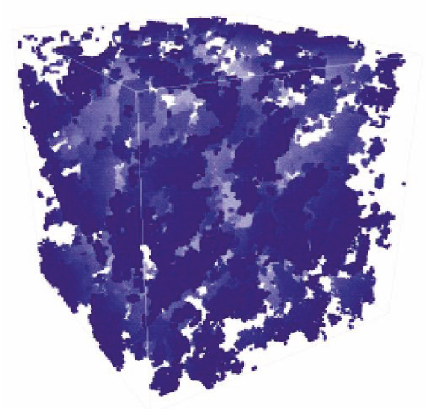
Figure 11: Reconstruction result of the 3D digital core using MPS method. Among them, the blue part is the pore, and the transparent part is the skeleton. It can be seen that even for shale rock, the long-range connectivity of the pore space of the 3D digital core obtained by the MPS method is still good. This shows that the MPS method can re fl ect the training image well and obtain the 3D digital core with long-range connectivity. Figure reprinted from